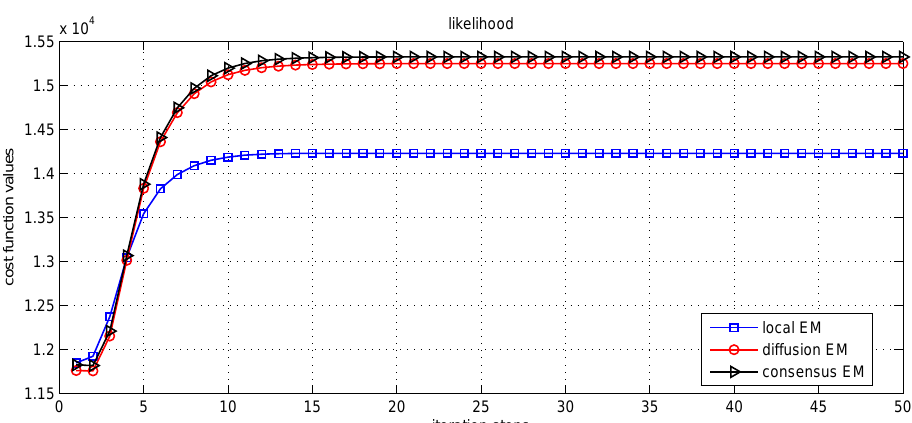
Figure 5. Likelihood function for different EM